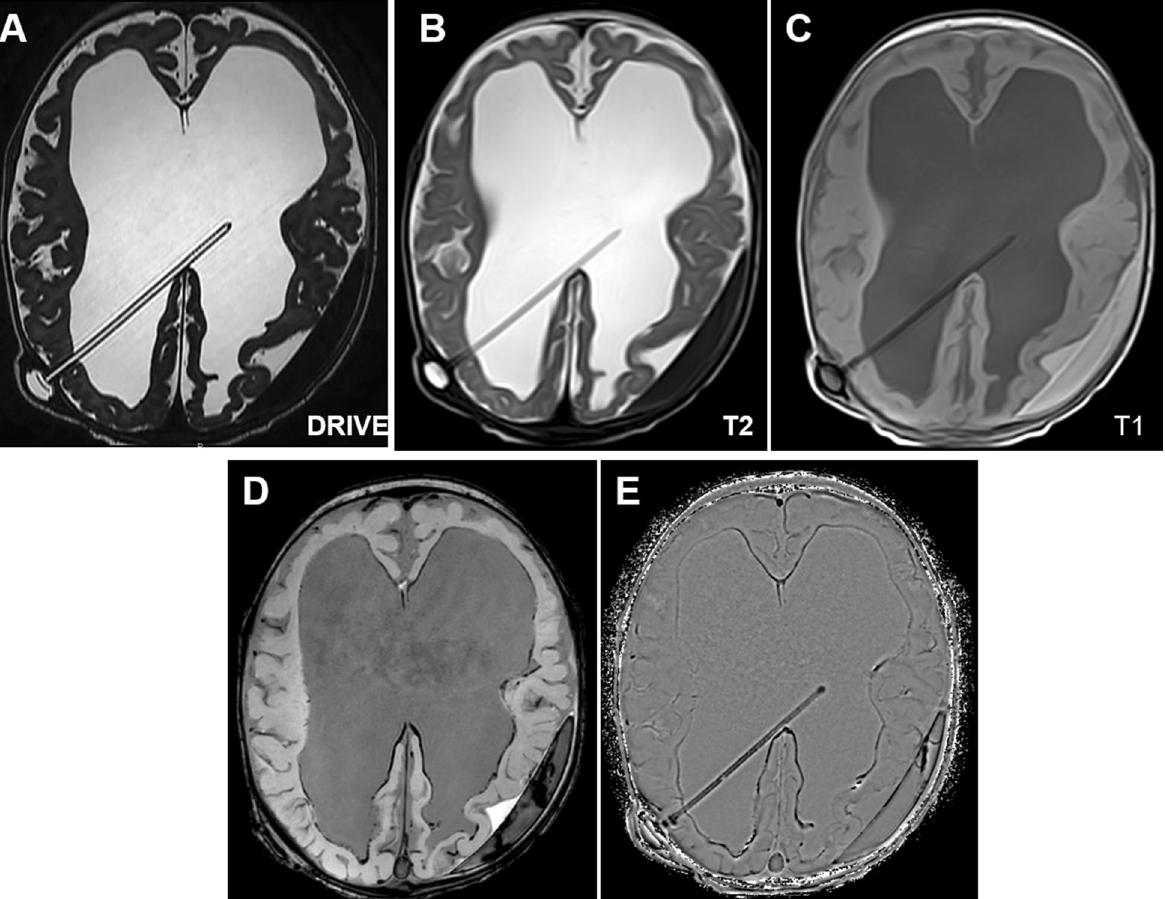
Fig. 4 A 7‑month‑old boy was referred for routine follow‑up. Left parieto‑occipital early subacute subdural hematoma that displays similar hypointense signal in both 3D‑DRIVE and T2‑WI and hyperintense signal in T1‑WI, related foci of blooming artifact in SWI ( D , E magnitude and phase images, respectively) with no related diffusion restriction (not shown). The proximal catheter and reservoir of the shunt are patent, both demonstrating luminal CSF signal (seen in A